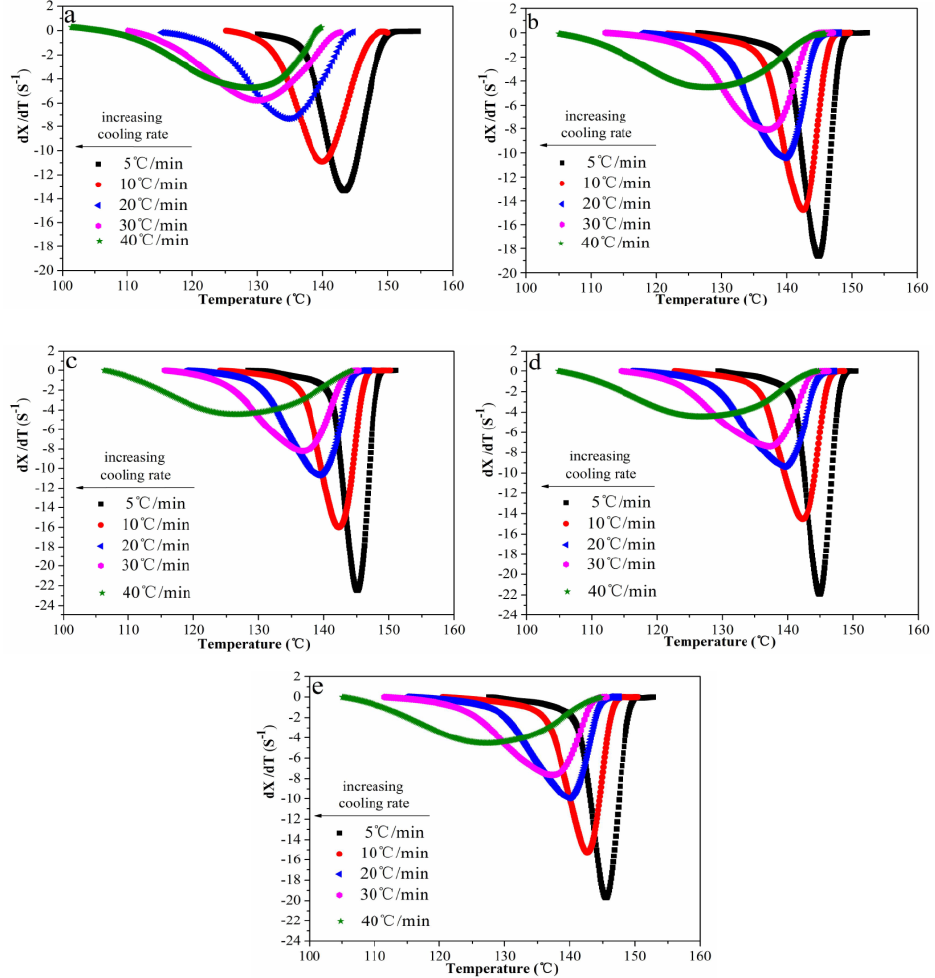
Figure 11. Crystallization rate (d X /d T ) as a function of temperature for POM/Ag nanocomposites with different Ag nanoparticle contents: ( a ) 0, ( b ) 0.1, ( c ) 0.5, ( d ) 1, ( e ) 2 wt % at the cooling rates of 5, 10, 20, 30 and 40 °C/min. Table 5. Parameters of Ziabicki analysis for the POM/Ag nanocomposites.